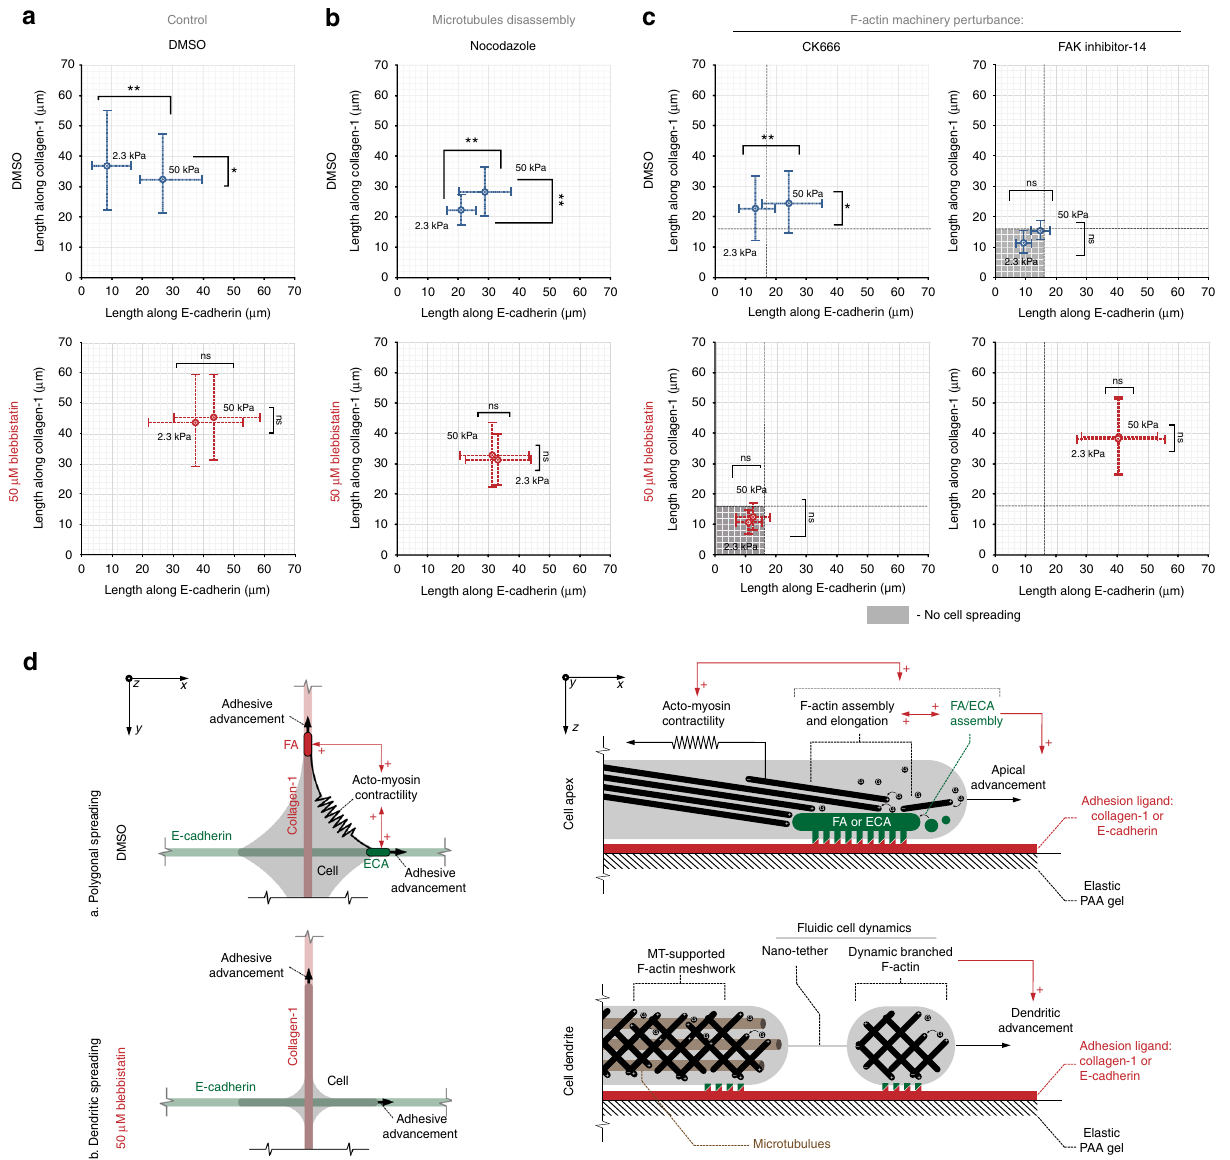
Fig. 8 Physical and molecular mechanisms governing bimodal sensing of contact guidance cues in carcinoma cells. a – c Summary of the bimodal cellular guidance sensing response for a control conditions, b disruption of microtubules, and c Arp2/3 and FAK inhibition, respectively, demonstrating a bimodal response for sensing guidance cues that depends on the magnitude of cell traction forces and two parallel contractile force-dependent mechanisms where FAK regulates the response in contractile cells and Arp2/3 regulates sensing in the low-traction state. The corresponding n values for a – c are shown in Supplementary Figure 10b. d Model of the carcinoma cell-sensing response in the contractile elastic state and the more fl uidic-like, low-traction dendritic state where protrusive forces from branched actin network dynamics drive adhesion-directed sensing of guidance cues. Number of replicates (independent experiments) for all measurement N = 5. Data are mean ± s.d., ns: no signi fi cant difference between groups, * p < 0.05, ** p < 0.001 (ANOVA). See also Supplementary Figure 10b for the raw data of population-wide individual cell spreading length measurements compiled into distribution